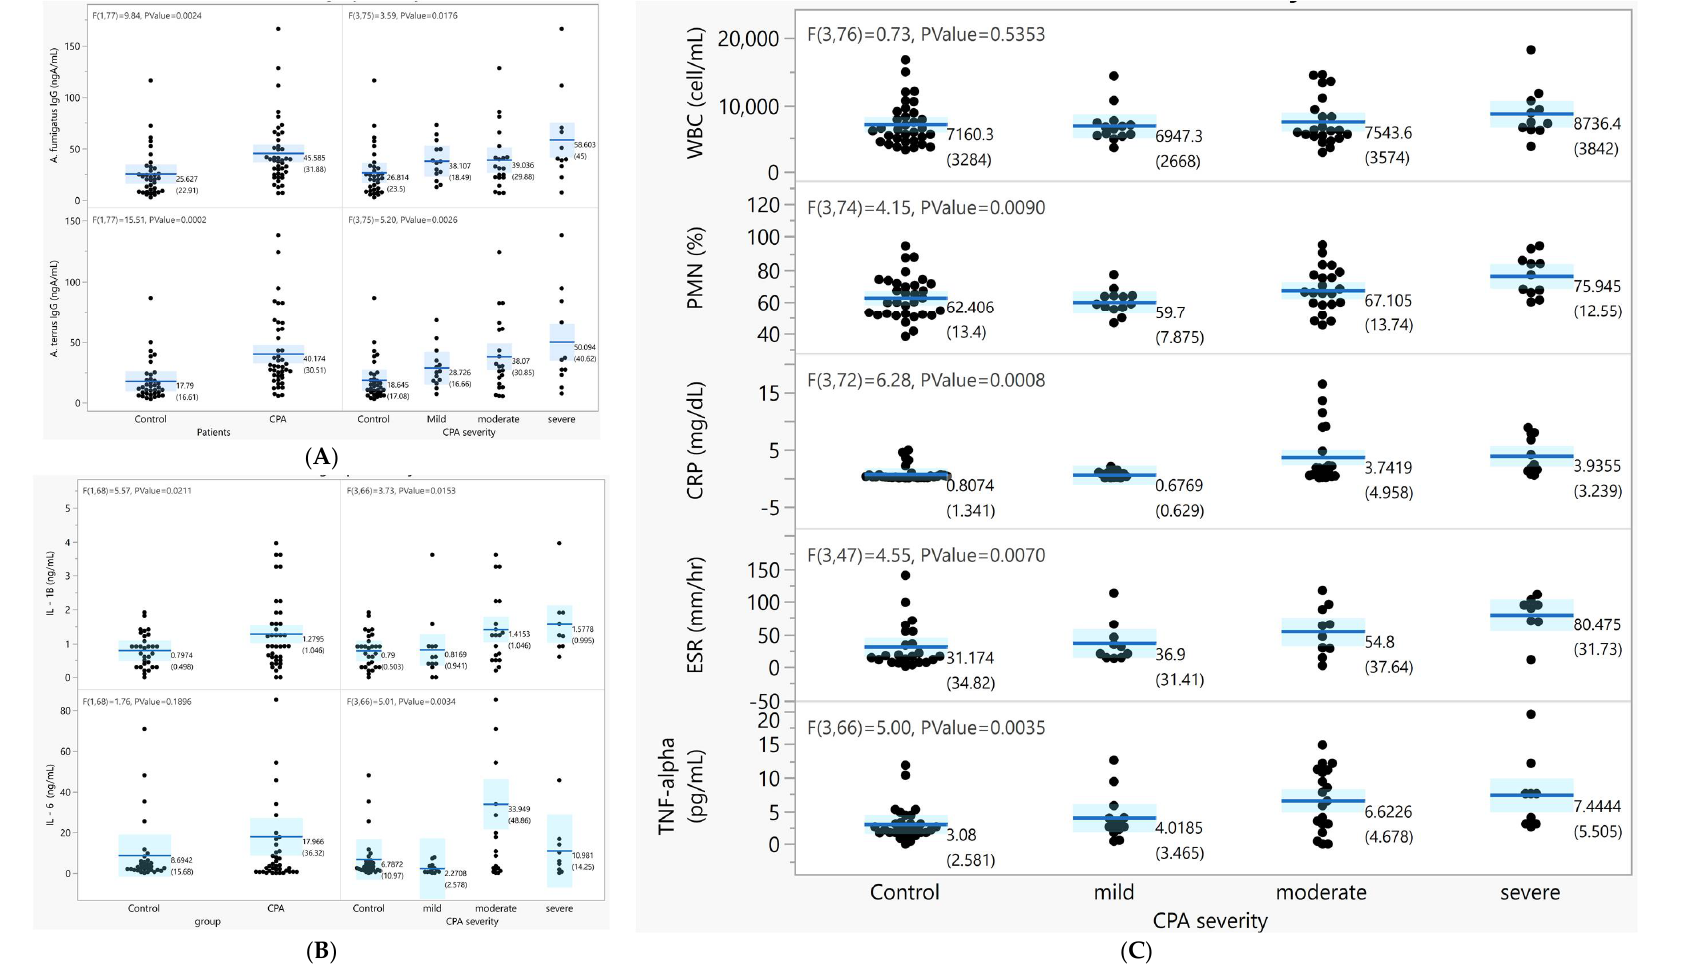
Figure 1. Association between the inflammatory cytokines, Aspergillus -specific IgG level, and CPA severity by visual severity. ( A ) The A. fumigatus and A. terreus IgG levels by disease group and by CPA severity. ( B ) Differences in the peripheral IL-6 and IL-8 levels (pg/mL) between the disease group and CPA severity ( p < 0.05). ( C ) Clinical laboratory measurement levels by disease group and CPA